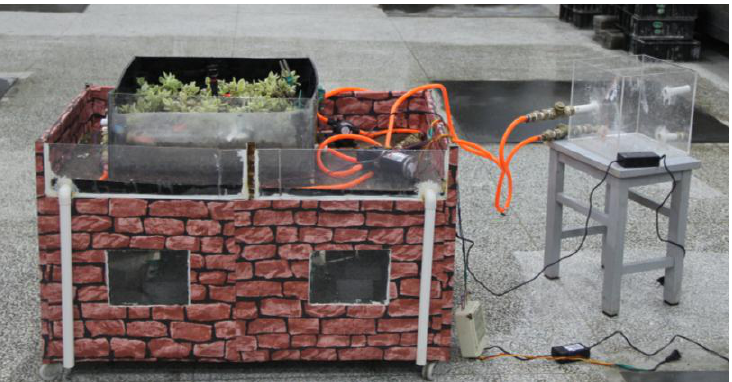
Figure 2. Model experimental device.